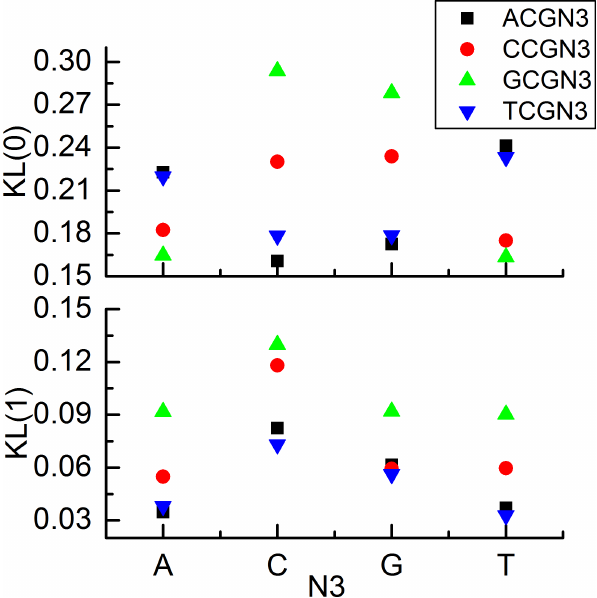
Fig 7. Methylation variation (above) and demethylation variation (below) in PMDs (chr1 of IMR90 cell lines).